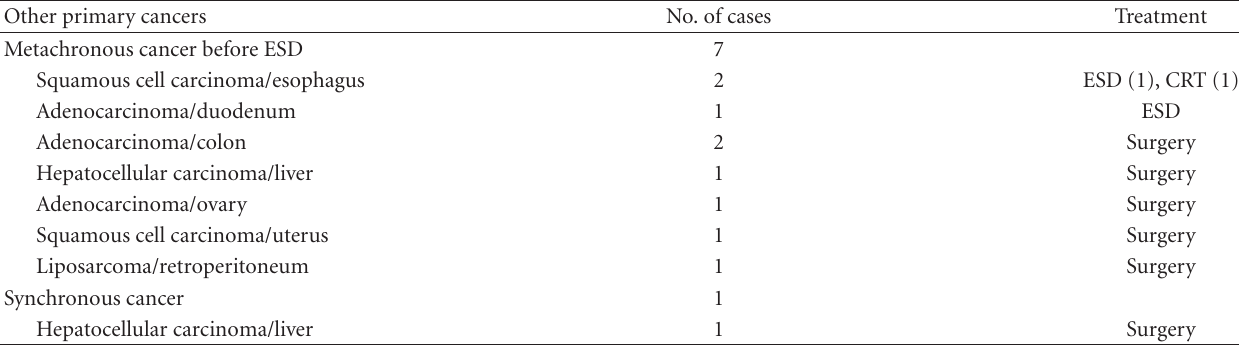
Table 2: Multiple cancers in other